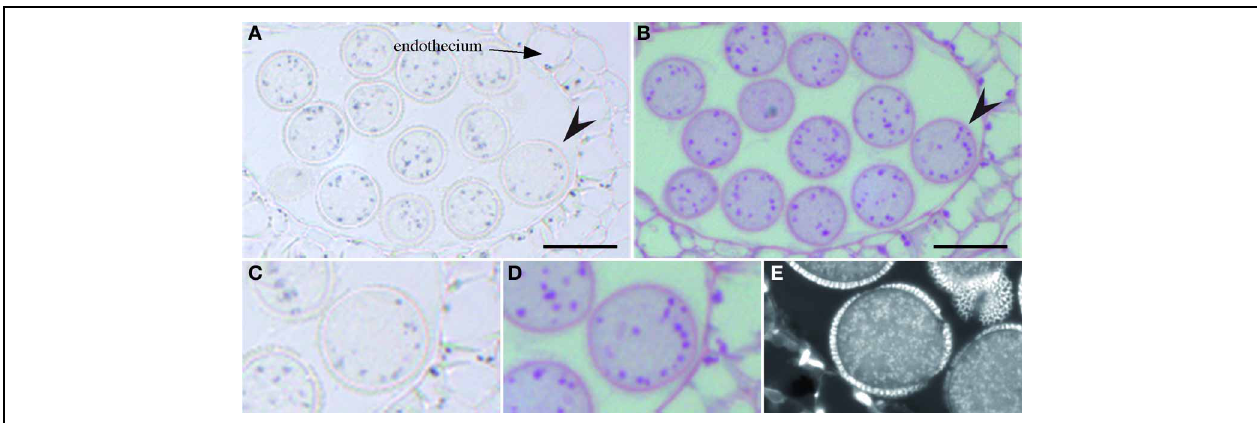
FIGURE 7 | Iron co-localizes with starch in pollen. Serial sections of the same anther were stained with either Perls/DAB (A,C) , periodic acid-Schiff (B,D) or DiOC 6 (E) . The arrow heads in (A , B) indicate the pollen grain that is magnified in (C,D) , respectively. Scale bars: 20 µ m.